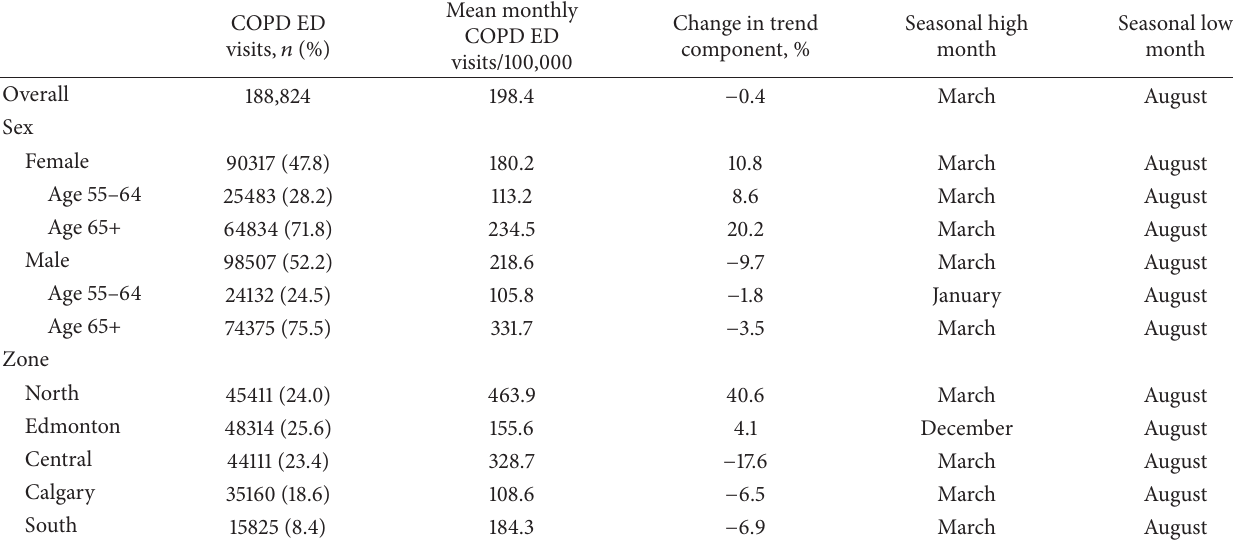
Table 1: Patient demographics and time series